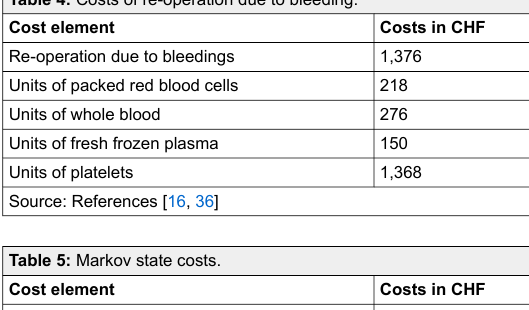
Table 5: Markov state costs.